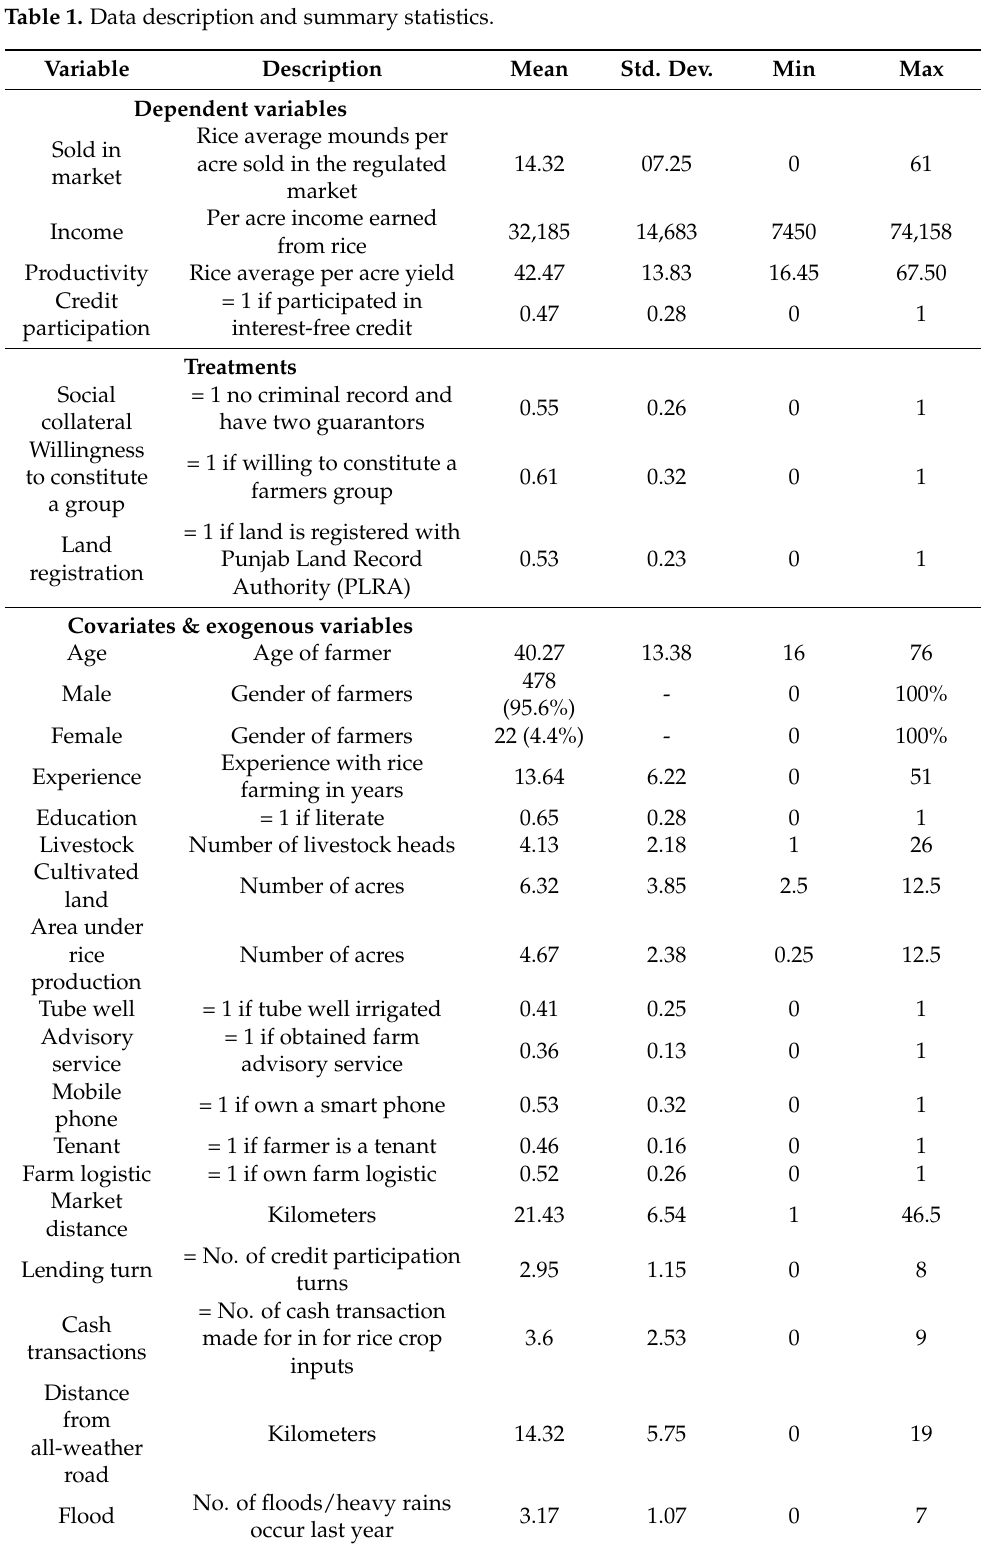
Table 1. Data description and summary